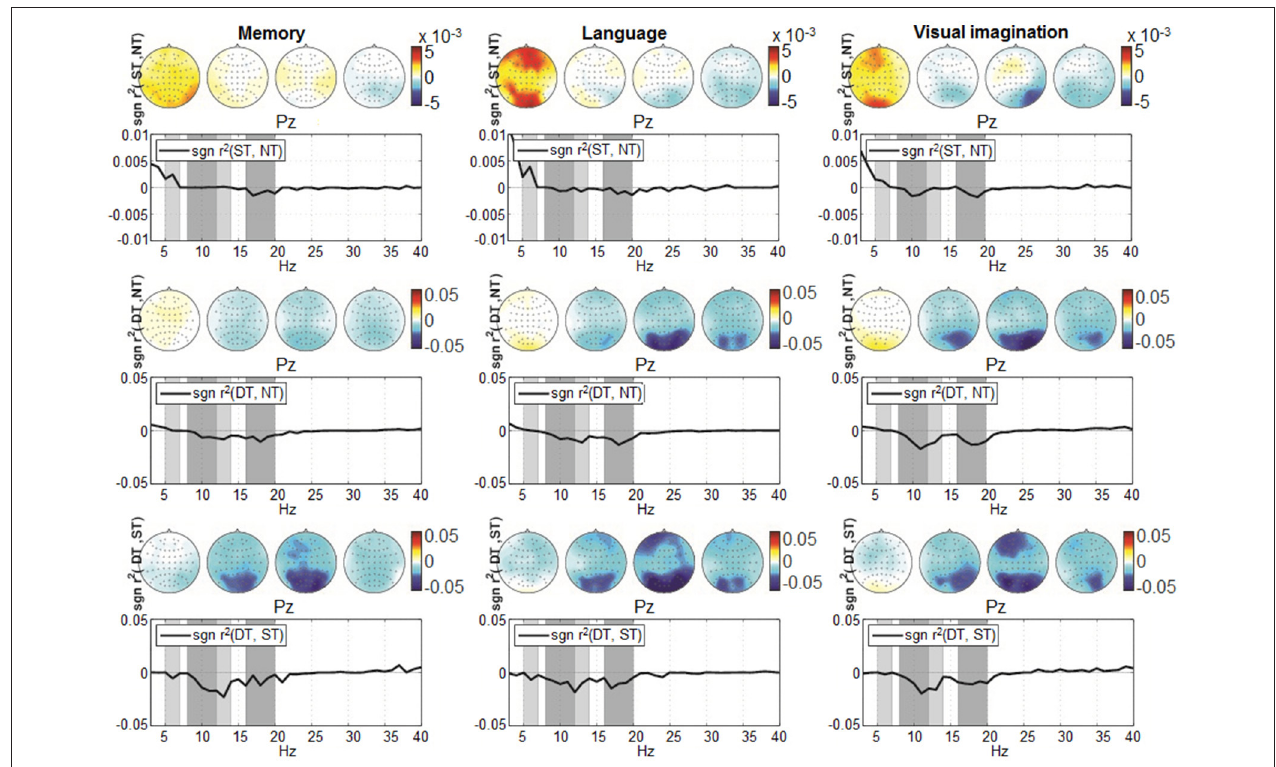
FIGURE 7 | Grand-average spectrum discrimination given by sgn r 2 at location Pz, computed over the entire trial timing (0–2,000 ms) in the frequency range from 3 to 40 Hz. The discrimination pairs ST-NT, DT-NT, and DT-ST are represented from top to bottom, while from left to right are represented according to the three conditions : memory , language, and visual imagination . The four scalp plots refer to discriminative signed r 2 -values, corresponding to θ (5–7 Hz), α (8–12 Hz; 12–14 Hz), β (16–20 Hz) frequency bands (shaded in gray). Note the upper graphs scale − 0.01 to 0.01, compared to the other scales − 0.05 to 0.05.